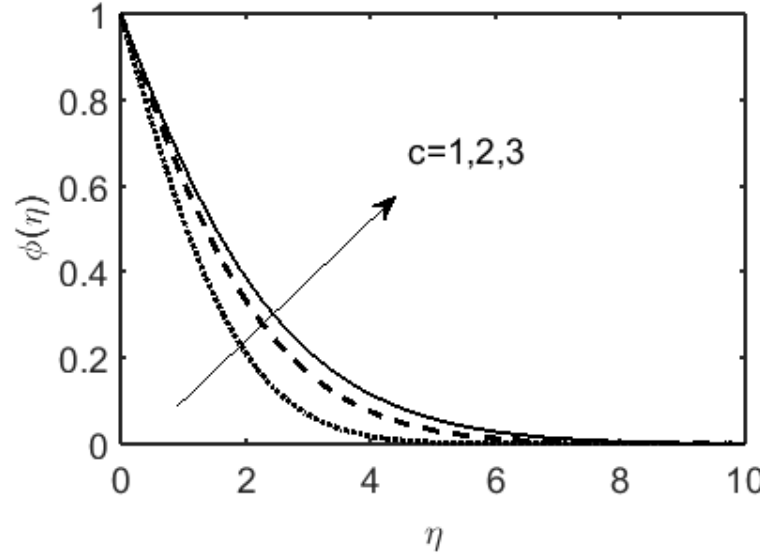
Figure 8. Impact of c on concentration.